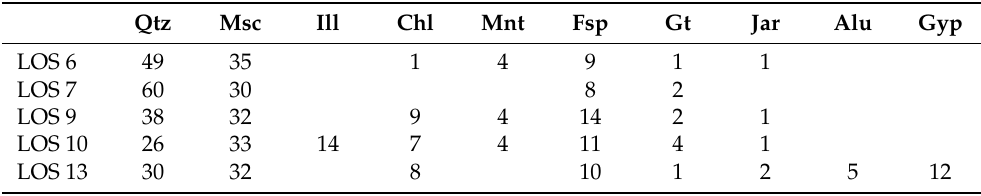
Table 3. Water leachable content of some PHEs in the studied samples. PHE